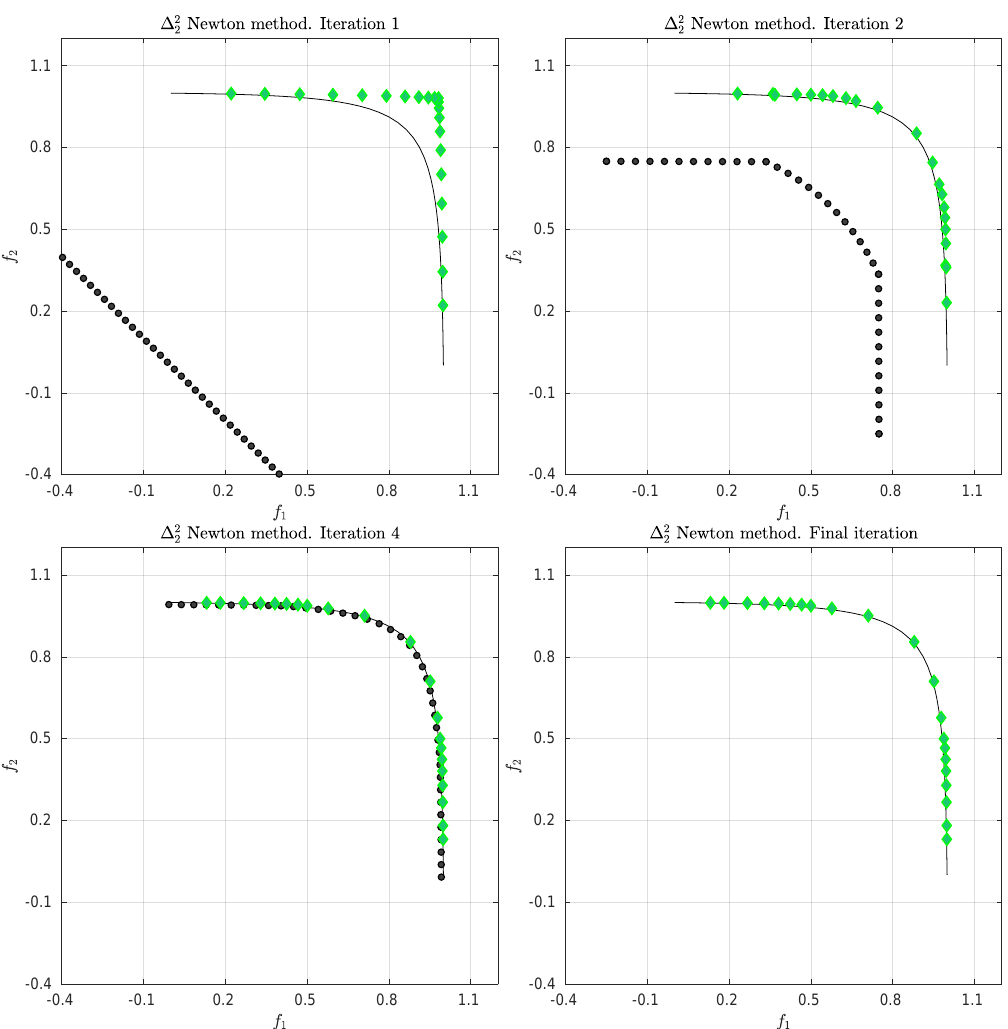
-Newton method to obtain the Pareto front of MOP (50) via the 2